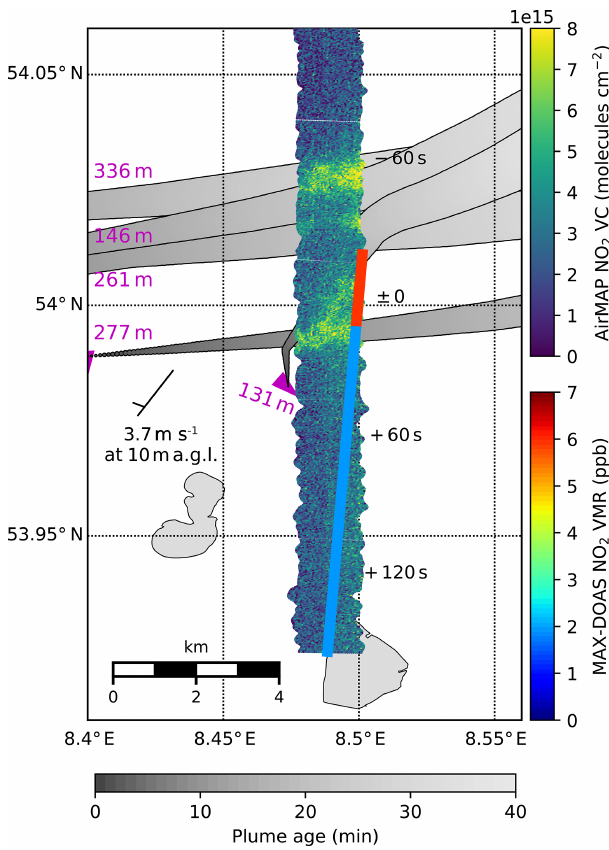
Figure 12. Map showing the MAX-DOAS path-averaged VMRs (colored lines) and AirMAP vertical columns of NO 2 (broad image stripe beneath) on 21 August 2013 around 09:43UTC (11:43LT). Magenta triangles show current ship positions and course, and ma- genta numbers denote the ship length. The modeled plumes (for the MAX-DOAS measurement time) are shown in gray, with the lightness of the gray shading representing the plume age. The time difference between AirMAP and MAX-DOAS measurements is in- dicated in the map at specific parts of the flight track. Wind direction and speed are shown with a meteorological wind